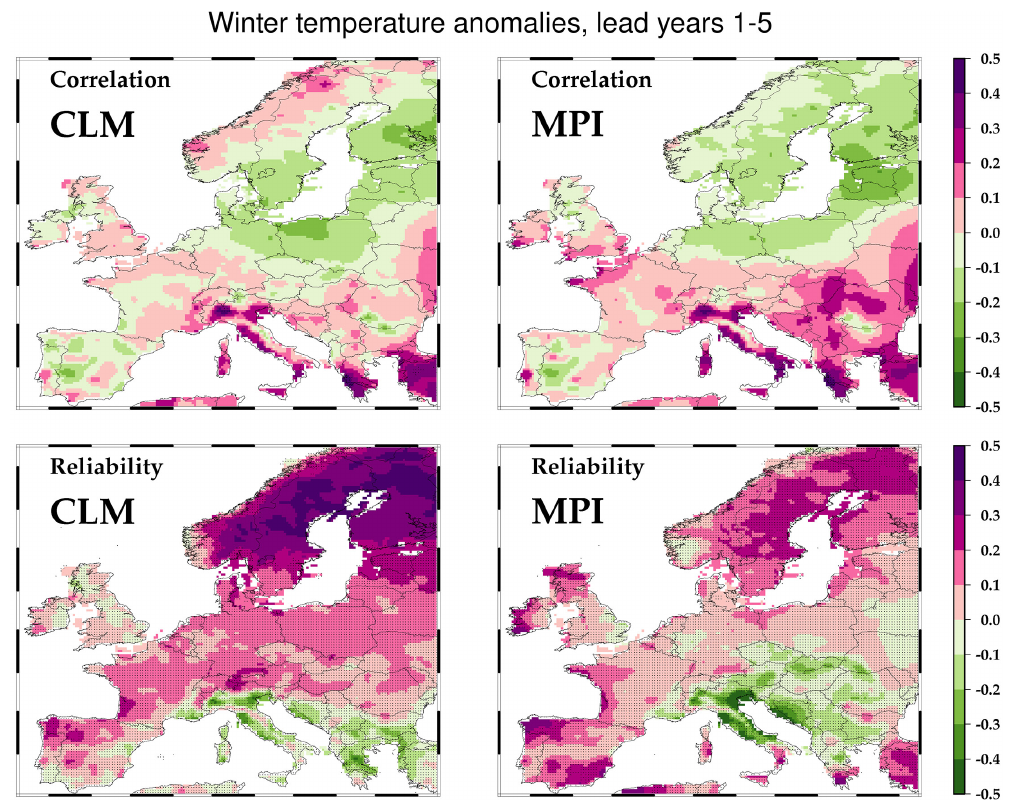
Figure 13. Winter half-year temperature anomaly means for lead years 1–5 from 1961 to 2010. The top panels show the correlation coefficient between E-OBS observations and CCLM (left) and MPI-ESM-LR (right). The bottom panels show the reliability of the CCLM (left) and MPI-ESM-LR (right) ensembles with respect to the E-OBS observations. Stippling indicates results, significant at the 10% level.